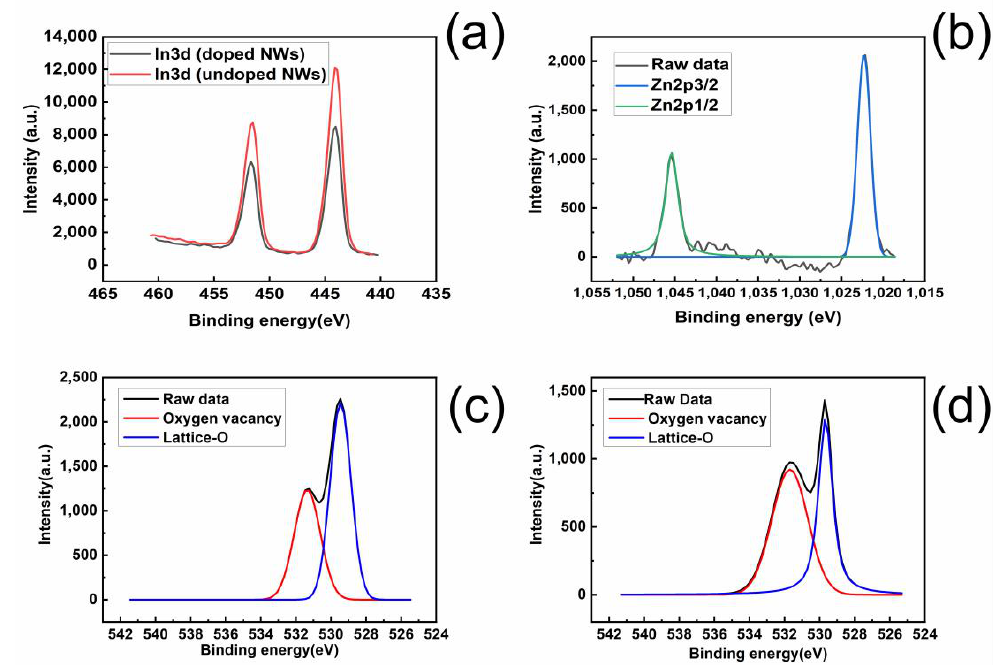
Figure 6. XPS analysis of substrate surface of: ( a ) undoped and zinc-doped In 2 O 3 nanowire for In3d peaks; ( b ) zinc-doped In 2 O 3 nanowire for Zn2p peaks; ( c ) undoped In 2 O 3 nanowire for O1s peaks; ( d ) zinc-doped In 2 O 3 nanowire for O1s peaks.